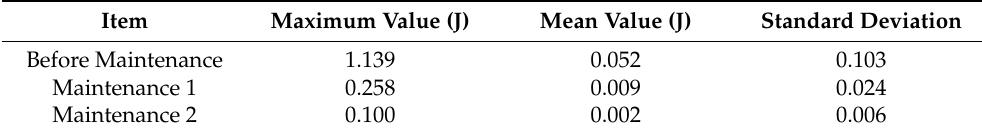
Table 5. Statistical values of the acceleration of pantograph